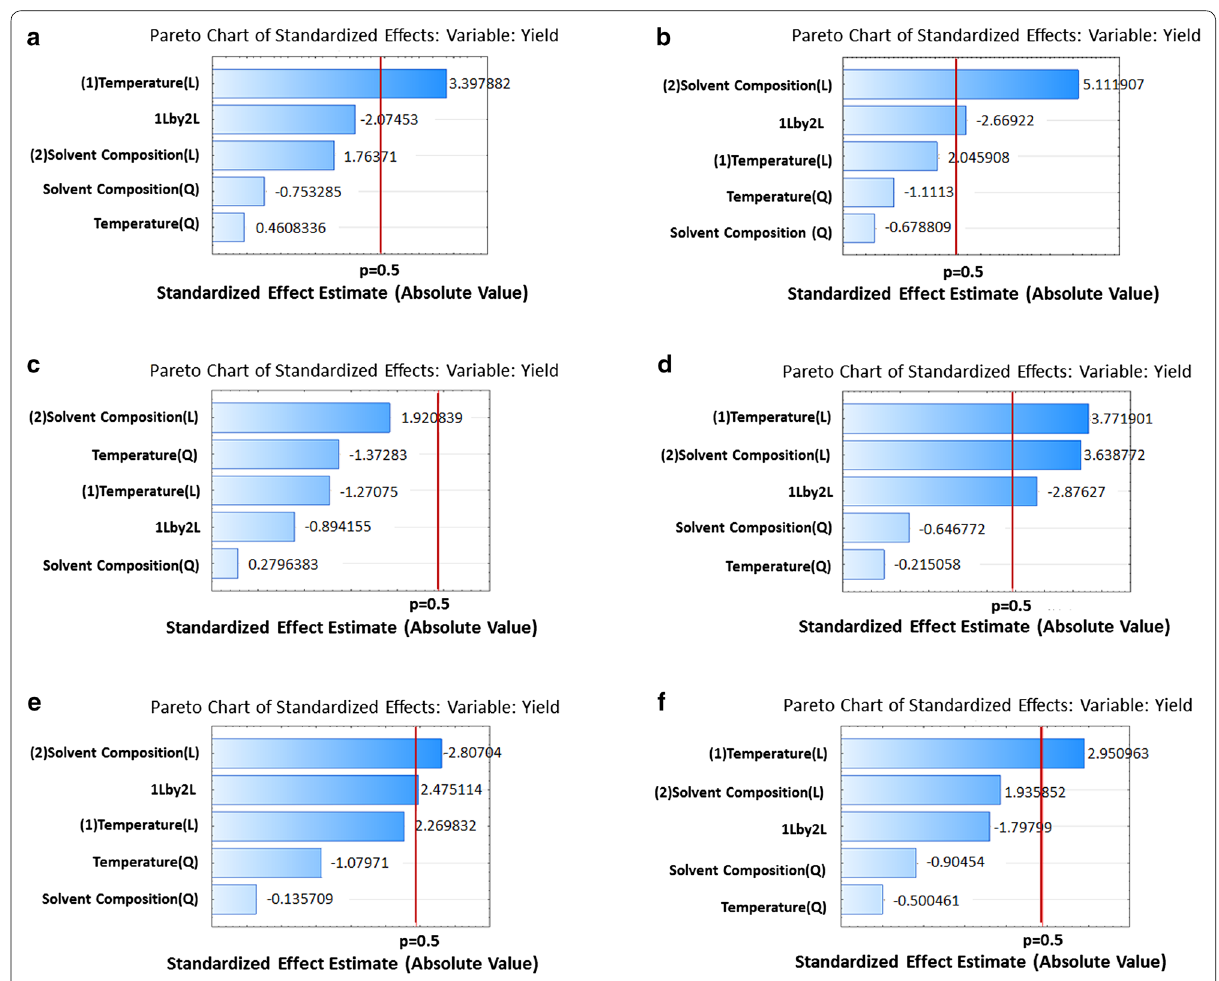
Fig. 6 Pareto chart of standardized effects of temperature and solvent composition on the extraction of diCQA and CA analogues: 3,4-diCQA ( a ), 3,5-diCQA ( b ), Cis -3,5-diCQA ( c ), 4,5-diCQA ( d ), CA ( e ) and CA isomer ( f